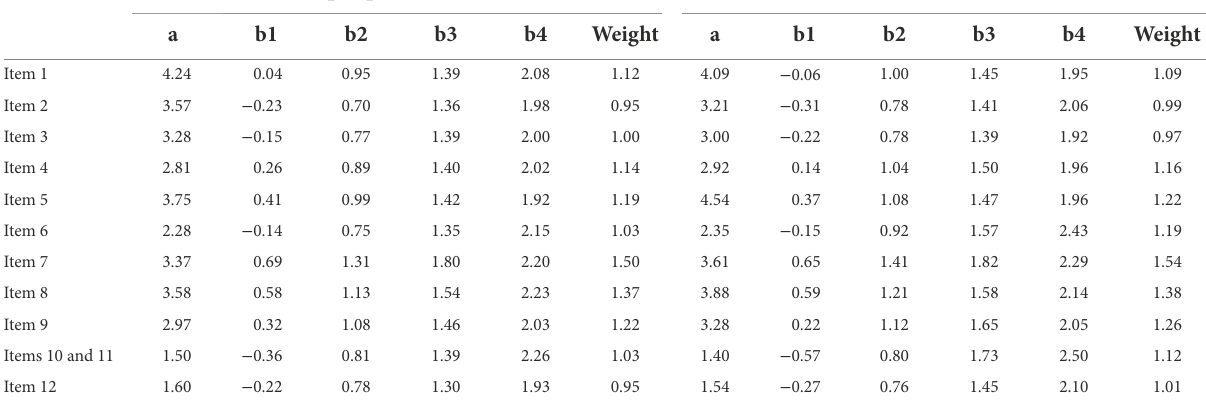
TABLE 6 Item parameters and